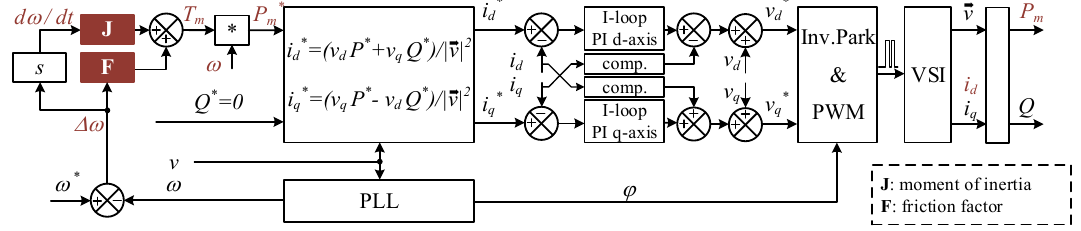
Figure 6. Control block diagram of the